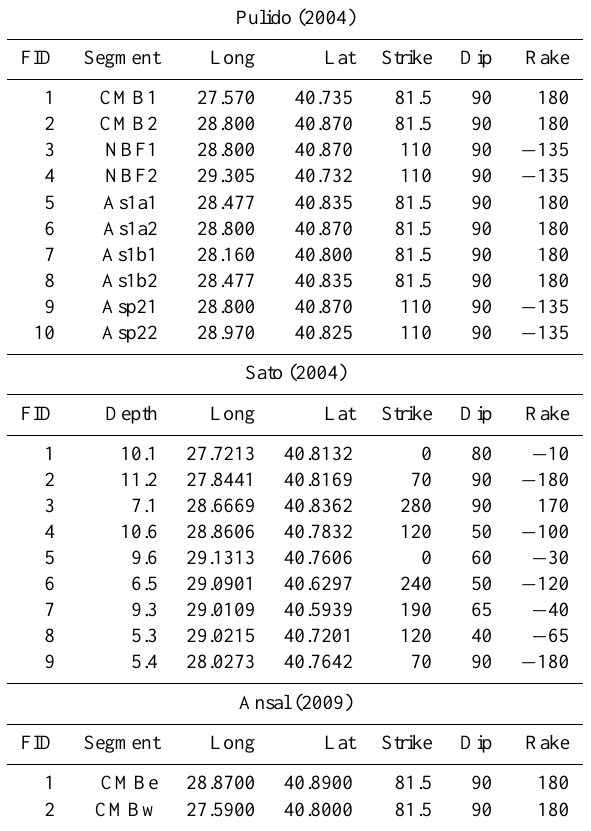
Table 4. Focal parameters of MMF (Sato et al., 2004; Pulido et al., 2004; Ansal et al., 2009).